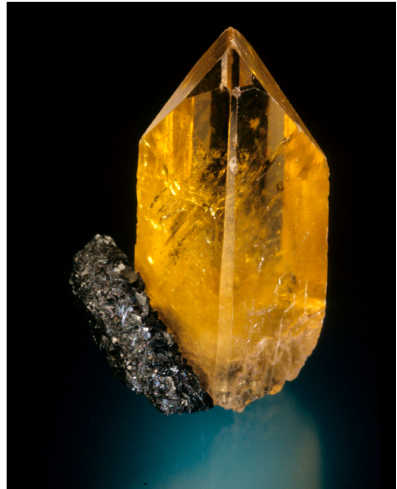
Figure 9. Barite and hematite, Chub Lake prospect. 3 cm. Alverson Collection, NYSM 20929. JS.